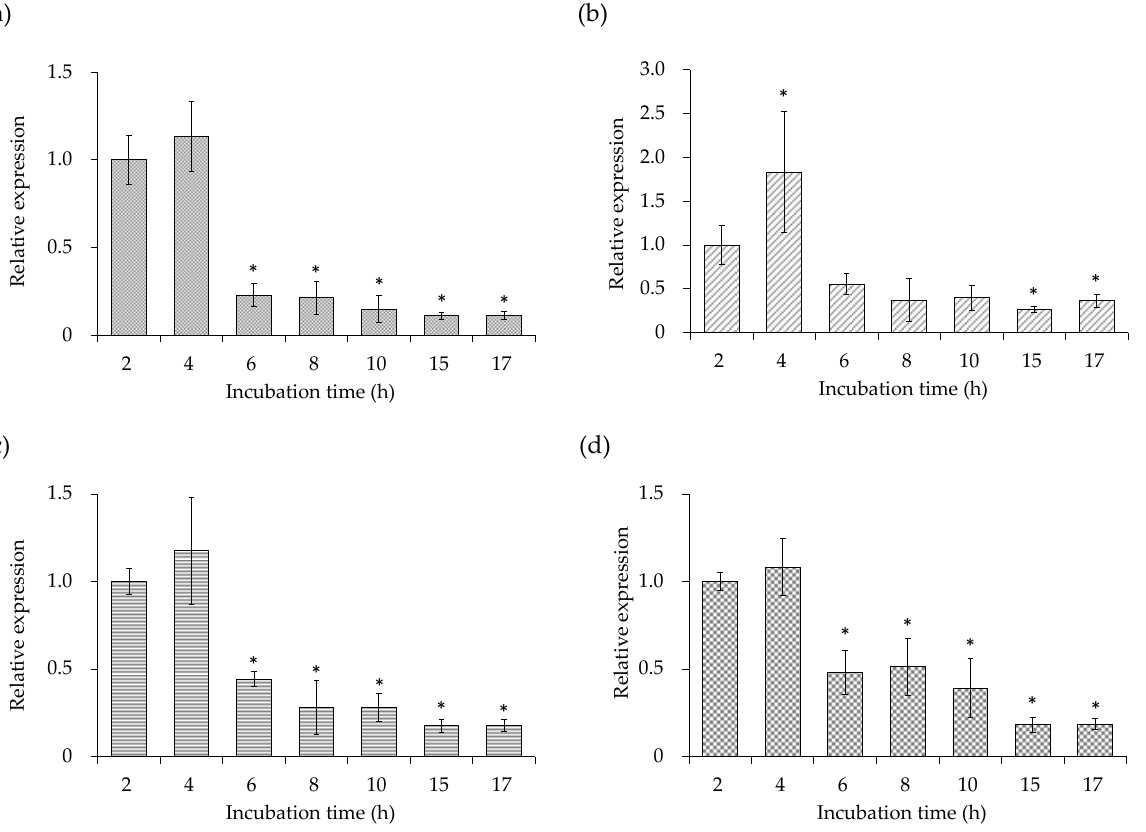
Figure 2. Time-dependent changes in the expression levels of cell membrane-related genes of Staphylococcus aureus C-29: ( a ) poly(glycerophosphate chain) d -alanine transfer protein (dltD) gene ( dlt D), ( b ) multiple peptide resistance factor (mprF) gene ( mpr F), ( c ) phosphatidylglycerol synthase (pgsA) gene ( pgs A), and ( d ) cardiolipin synthase (cls2) gene ( cls 2). S. aureus C-29 (10 8 cells/mL) were inoculated into BHI and incubated at 37 ◦ C with shaking. Bacterial cells were collected after 2, 4, 6, 8, 10, 15, and 17 h. Then, RNA extraction and real-time RT PCR were performed. The data are expressed as the mean ± SE of three or more independent experiments. * Indicates p < 0.05 compared with 2 h incubation